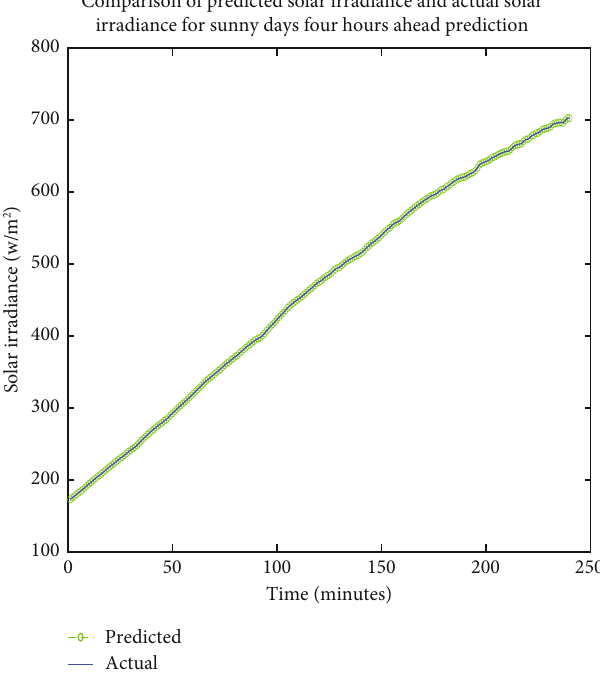
Figure 13: Comparison of predicted solar irradiance and actual solar irradiance for sunny day four-hour-ahead